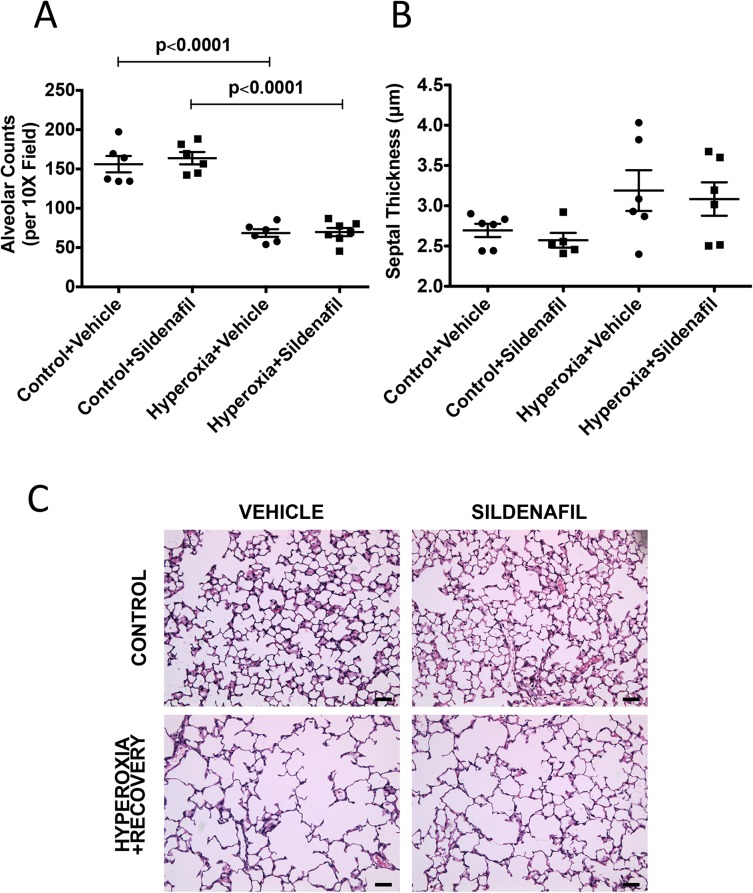
Sildenafil treatment during recovery does not affect hyperoxia-induced decreases in alveolar counts.Mice were exposed to hyperoxia or room air for 14d, followed by recovery in room air for an additional 7d ± sildenafil or vehicle. H&E sections were imaged, and (A) alveolar counts and (B) septal thickness were measured (n = 5–7 animals per group). (C) Representative H&E lung sections are shown for vehicle-treated control, vehicle-treated hyperoxia + recovery, sildenafil-treated control, and sildenafil-treated hyperoxia + recovery. Bar = 50 μm. Data are expressed as dot plots with each dot representing individual animals with means and SEM represented by horizontal lines. Results were analyzed by ANOVA with post-hoc Bonferroni’s analysis.